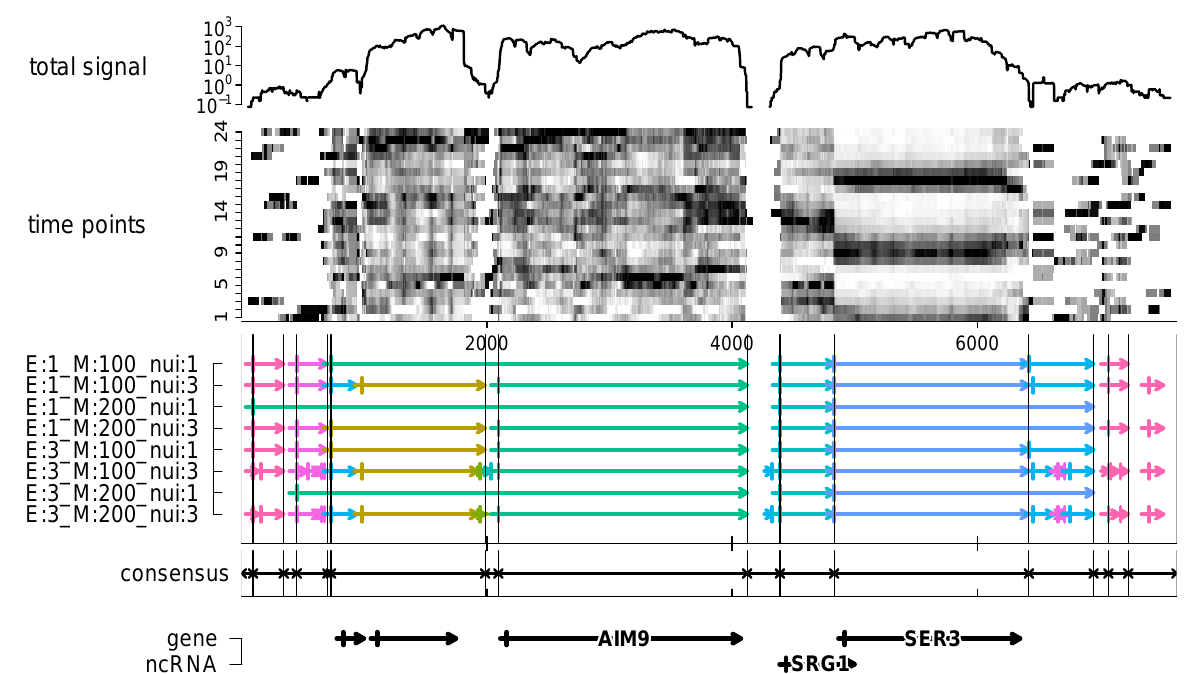
Figure 3. Alternative segmentations of the yeast transcriptome data shown in Figure 1 (here, the coverage time-series is shown as gray-values and the logarithms of the total coverage). Below, we show eight alternative segmentations computed with segmenTier [11] with different parameter settings. The consensus segments, computed for potential e ( z ) = z 2 /2, match very well with the expectations from visual inspection of the data and from the annotation of yeast the genome (bottom). SRG1 is a non-coding RNA that represses the adjacent SER3 gene by transcriptional interference [35].